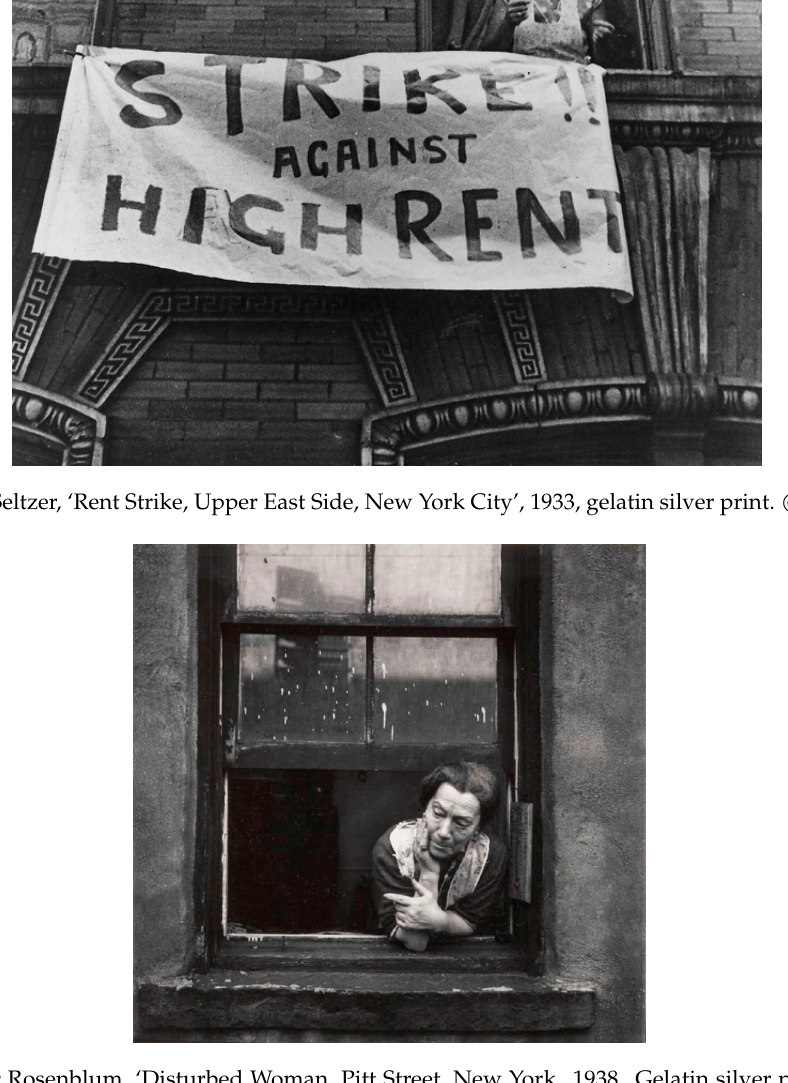
Figure 6. Walter Rosenblum, ‘Disturbed Woman, Pitt Street, New York. 1938. Gelatin silver print, 19.7 cm × 21.6 cm. © 2019. Photo The Jewish Museum/Art Resource/Scala,